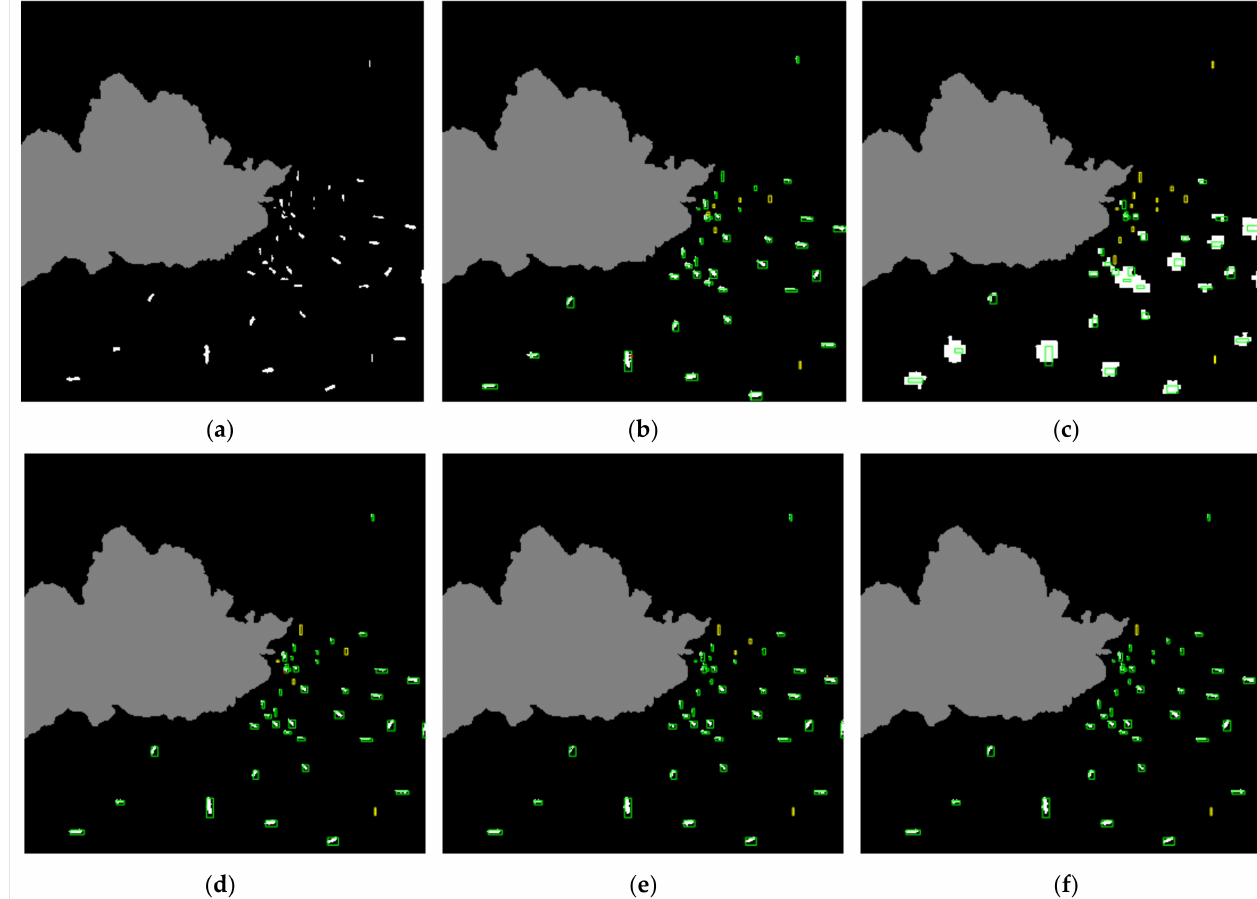
Figure 10. Detection results from GF-3 area I. ( a ) Ground-truth image. ( b ) SO-CFAR. ( c ) SP. ( d ) T3 + SVM. ( e ) PCP + SVM. ( f ) Proposed method. (Green: correct detection, yellow: missed detection, red: false